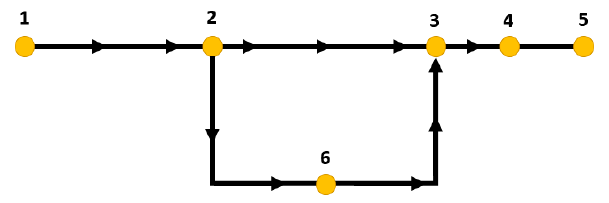
Figure 1. Simple water network.